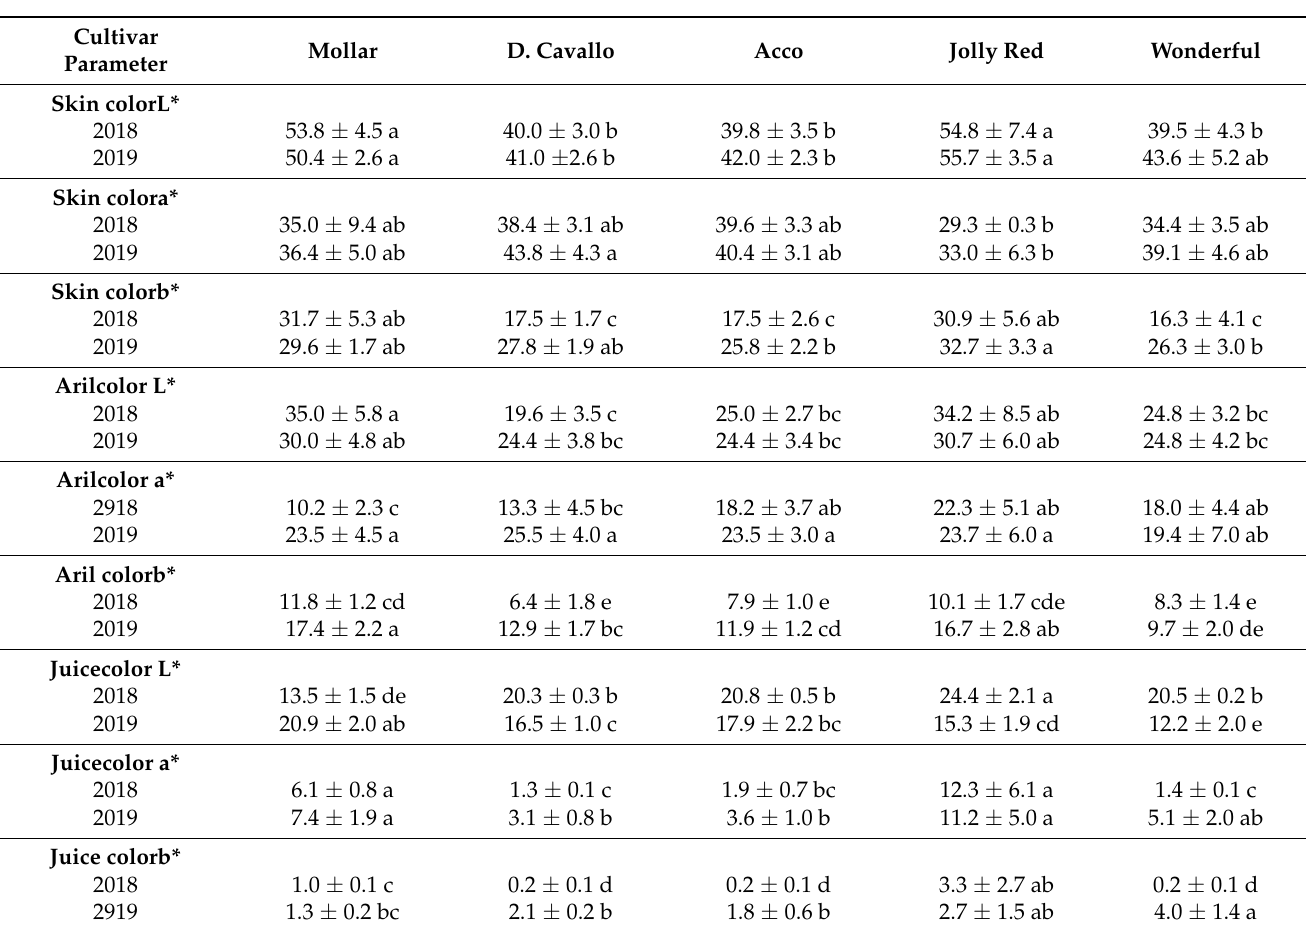
Table 4. Characteristics of skin, aril and juice colors of different pomegranate cultivars in 2018